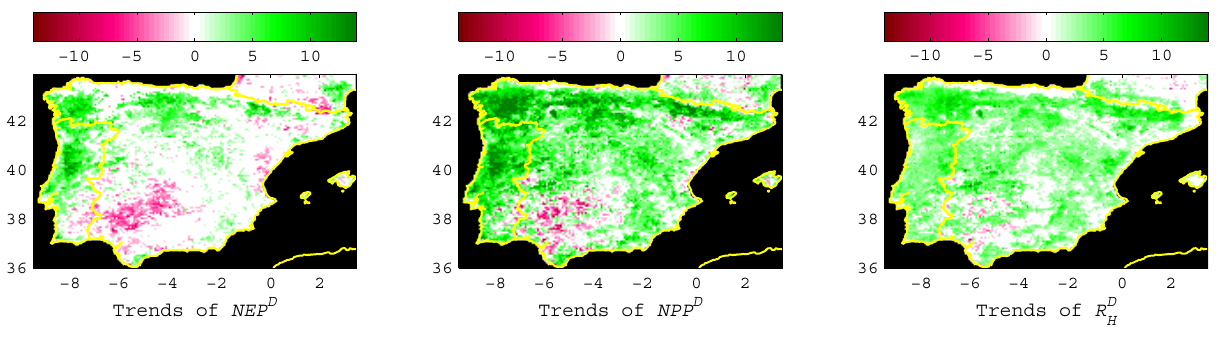
Fig. 8. Mean significant trends in NEP D , NPP D and R D (gCm − 2 yr − 2 ). The trends in fluxes in each pixel are considered significant when H for all prescribed η s the slopes are significant ( α < 0 . 05), systematically positive or systematically negative and its absolute magnitude at least 1.5gCm − 2 yr − 2 . The mapped values report the average of all the significant